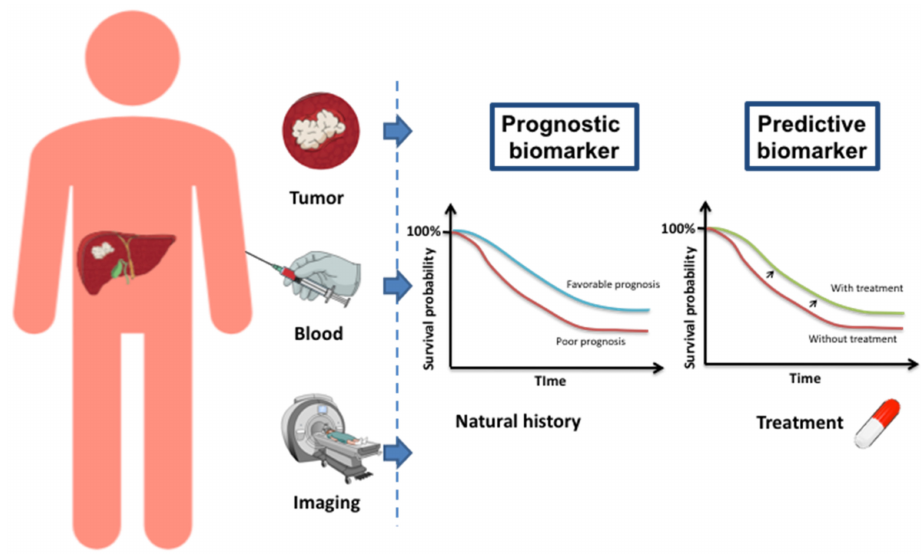
Figure 2. The difference between a prognostic and a predictive